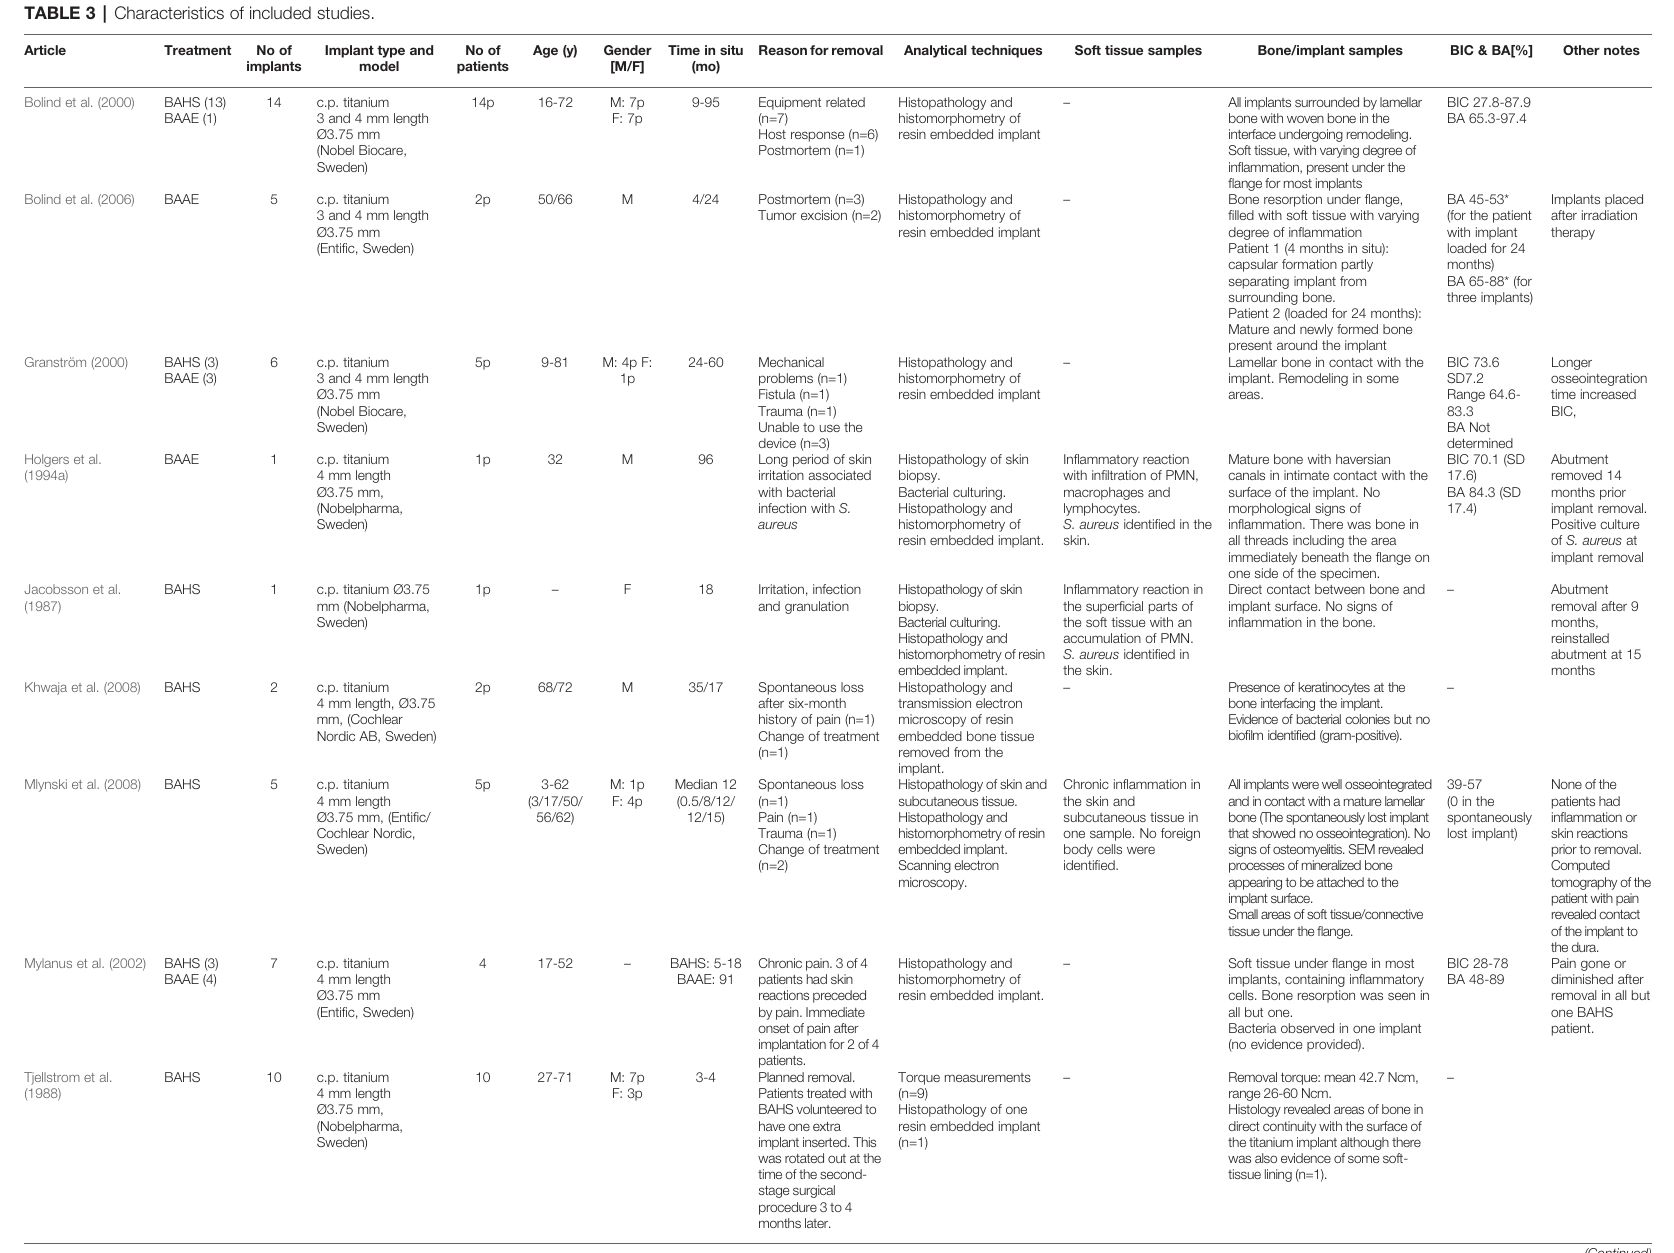
TABLE 3 | Characteristics of included